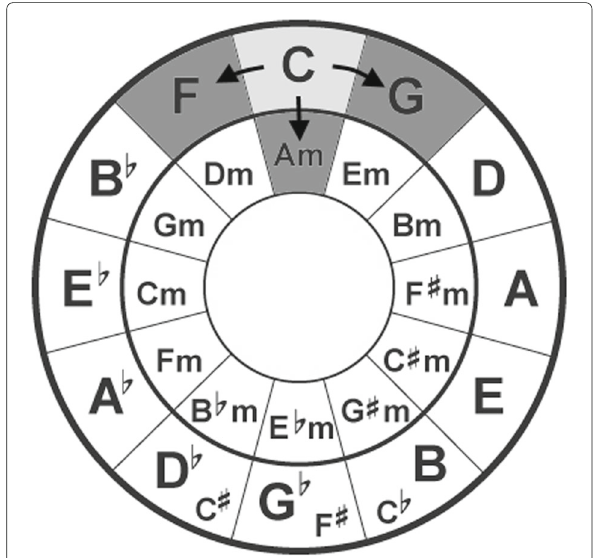
Fig. 9 Illustration of the circle of fifths and allowed key changes in the DJ system. For example, if the key of the current song is C major (light gray), the allowed key changes are one perfect fifth up (G major, the dominant key), one perfect fifth down (F major, the subdominant key) or changing to the relativekey (A